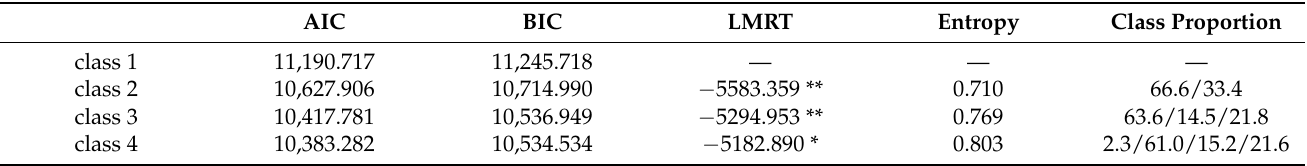
Table 1. Model fit indices of